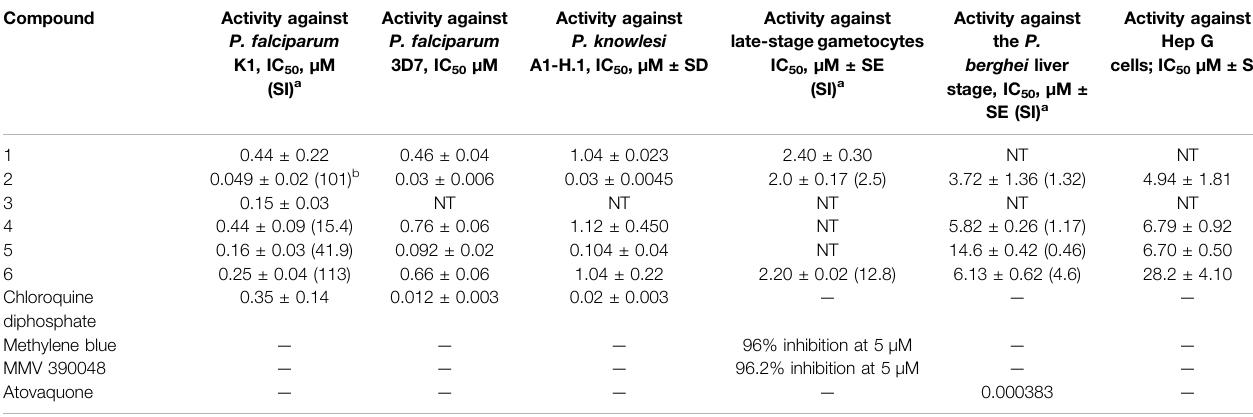
TABLE 1 | In vitro activities of 1 – 6 against blood- and liver-stage malaria parasites.